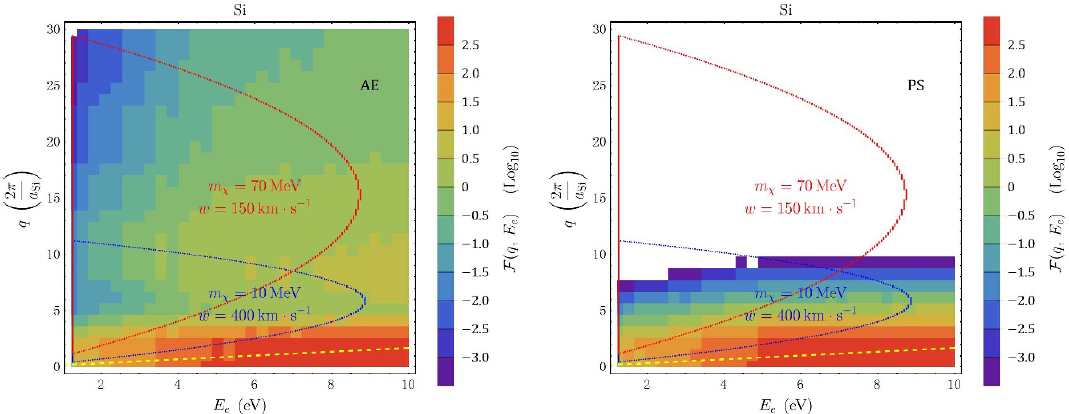
Figure 6 . Crystal form factor ( q, E e ) defined in eq. (4.3) calculated from the AE ( left ) and F PS ( right ) approaches, respectively. The area enveloped in red ( blue ) represents the parameter region relevant for the total excitation event rate for parameter m χ = 70 MeV, w = 150 km ( m χ = 10 MeV, w = 400 km s − 1 ). Only the region above the yellow dashed line is kinetically · allowed for the galactic DM distribution. See text for